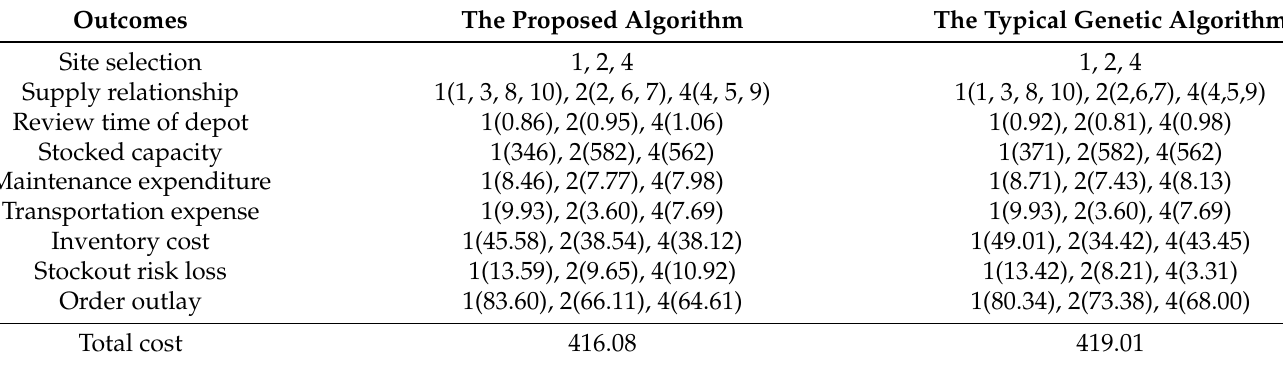
Table 6. Configurations and outcomes of the two algorithms.